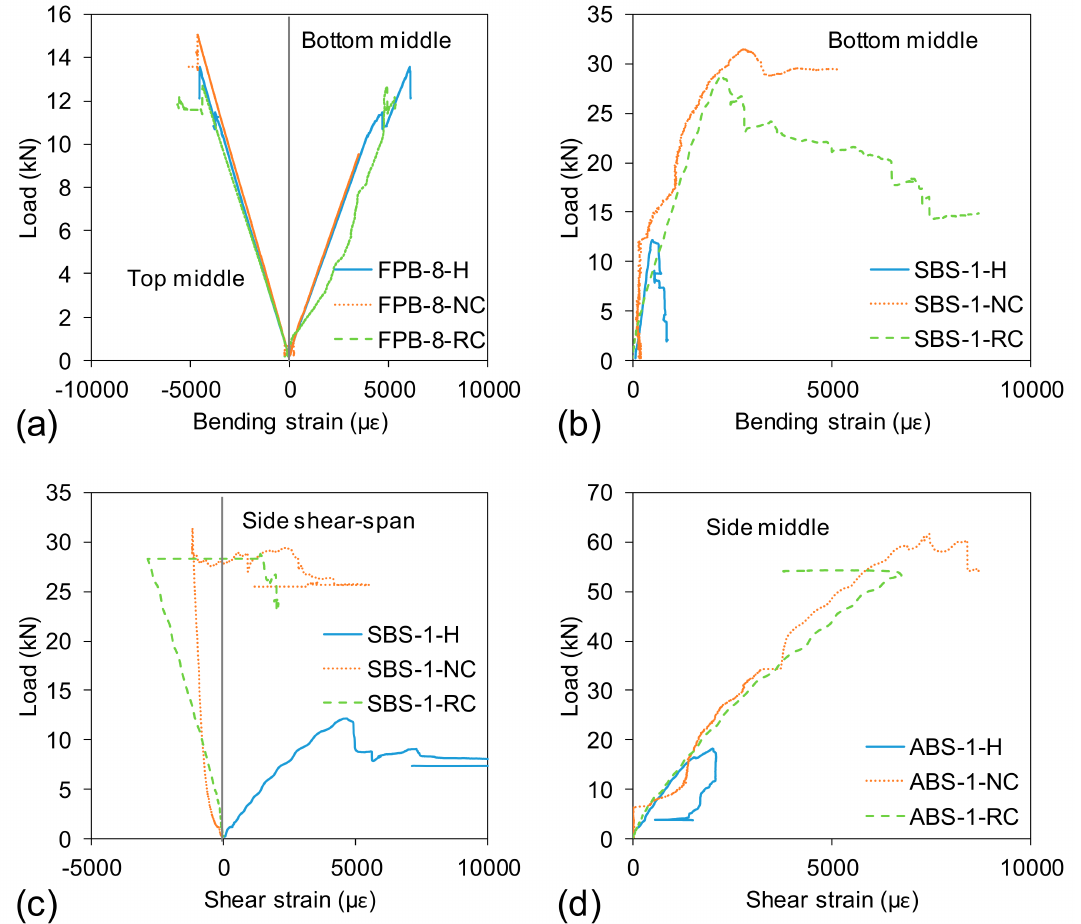
Figure 6. Total applied load–strain behaviour: ( a ) bending strain under FPB, ( b ) bending strain under SBS, ( c ) shear strain under SBS and ( d ) shear strain under